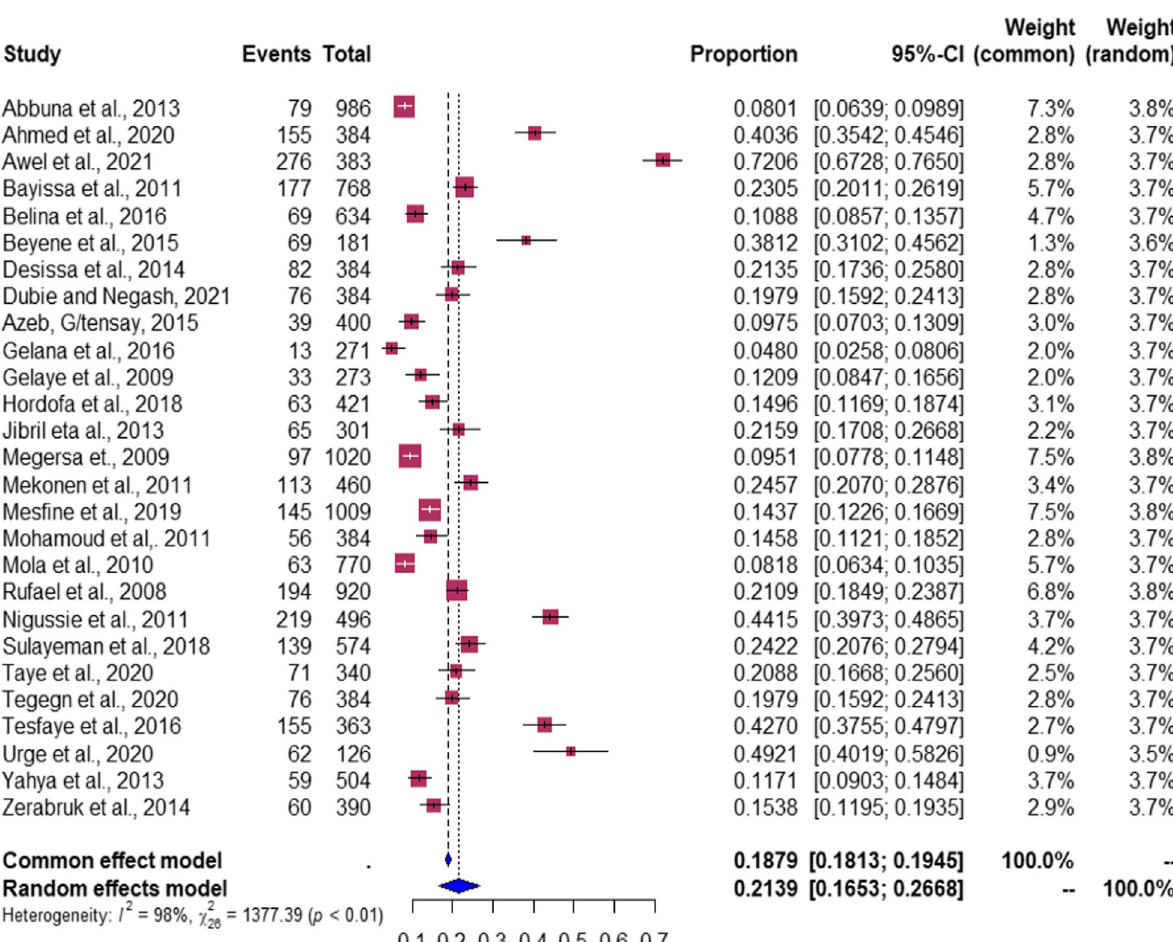
Fig. 3 Forest plot visualizing the varying FMD sero-prevalence reported for each included publication in the meta-analysis. Weightage given to each included publication by both Random Effects and Fixed Effect models have been shown for rigorous comparison. “Total” refers to the number of cattle in each publication, while “Events” refers to the number of FMD-seropositive cattle. “Proportion” reports the FMD prevalence for each